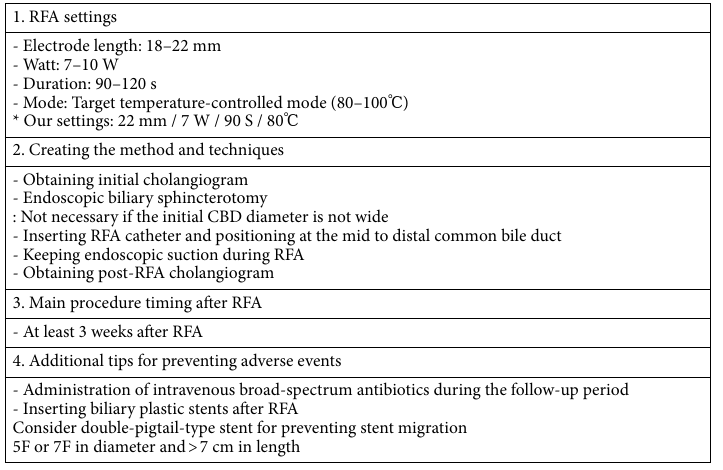
Table 4. Our guidelines for creating an optimal benign biliary stricture animal model. RFA, radiofrequency ablation; CBD, common bile